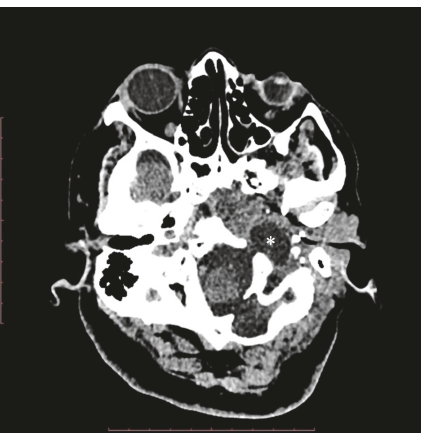
Figure 1: Axial CT image with bone window settings shows enlargement of left jugular foramen (∗) .